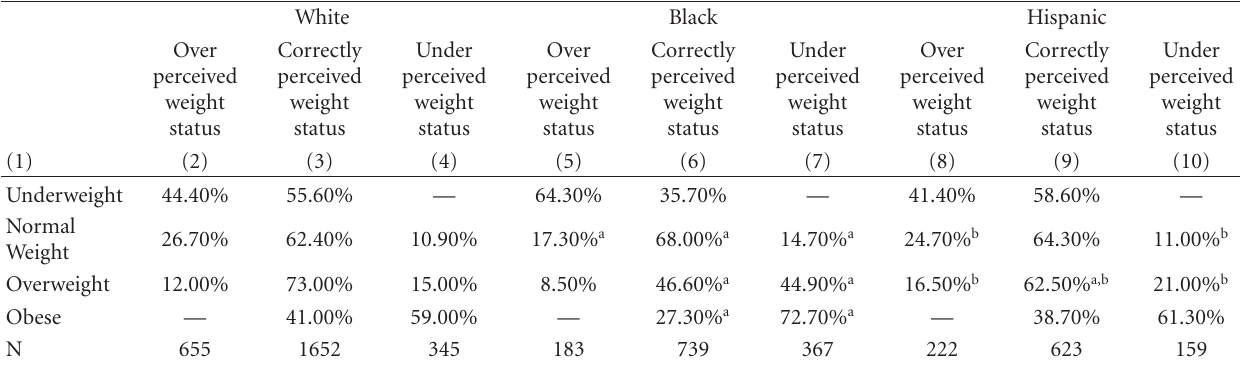
Table 2: Frequencies of weight perceptions by race and ethnicity and by weight categories. White Black Hispanic